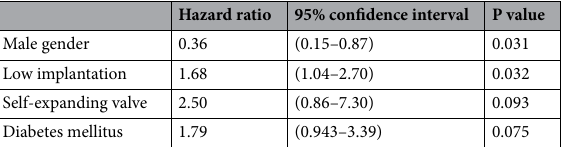
Table 2. Multivariate analysis for predictors of post-TAVR conduction